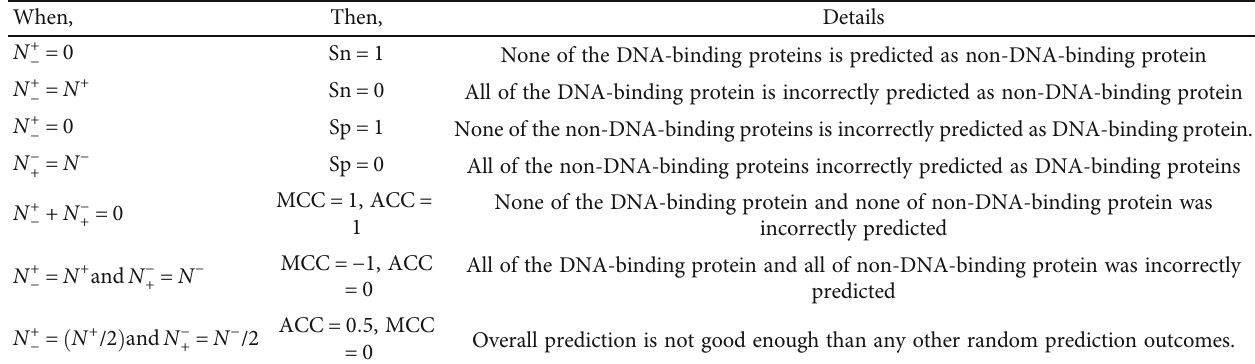
Table 3: Description of possible values.